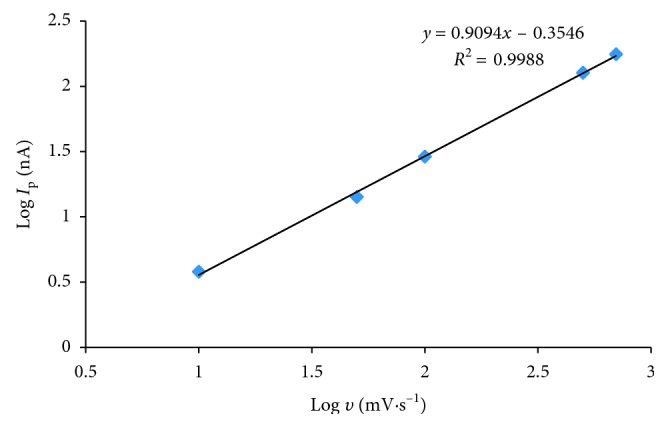
Cyclic voltammetry current (log Ip) vs. log ʋ plot for 10−6 mol·L−1 AO : Eacc = 0 V, tacc = 30 s scan rate from 10 mV·s−1 to 700 mV·s−1.